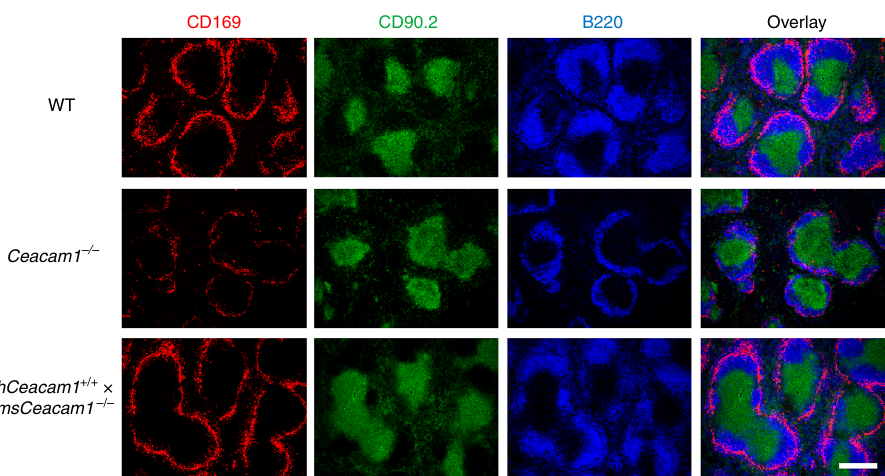
Fig. 2 Lack of CEACAM1 in fl uences splenic architecture. Representative immuno fl uorescence of sections from spleens of naive wild-type (WT), Ceacam1 – / – , and hCeacam1 + / + × msCeacam1 – / – mice after staining for marginal zone macrophages (CD169, red), T cells (CD90.2, green), and B cells (B220, blue) ( n = 4 – 5 per group). Scale bar, 300 µ m. One slide representative of four or fi ve slides